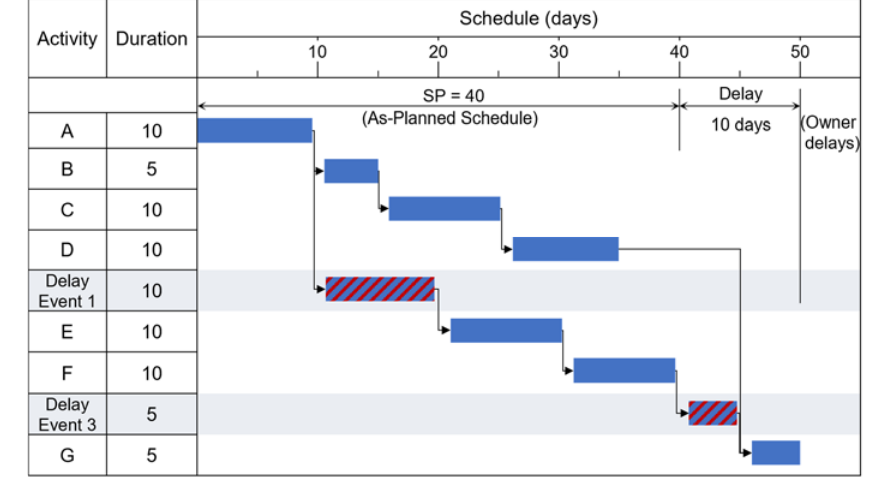
Table 1. Summary of the results of delay analysis. Alternative